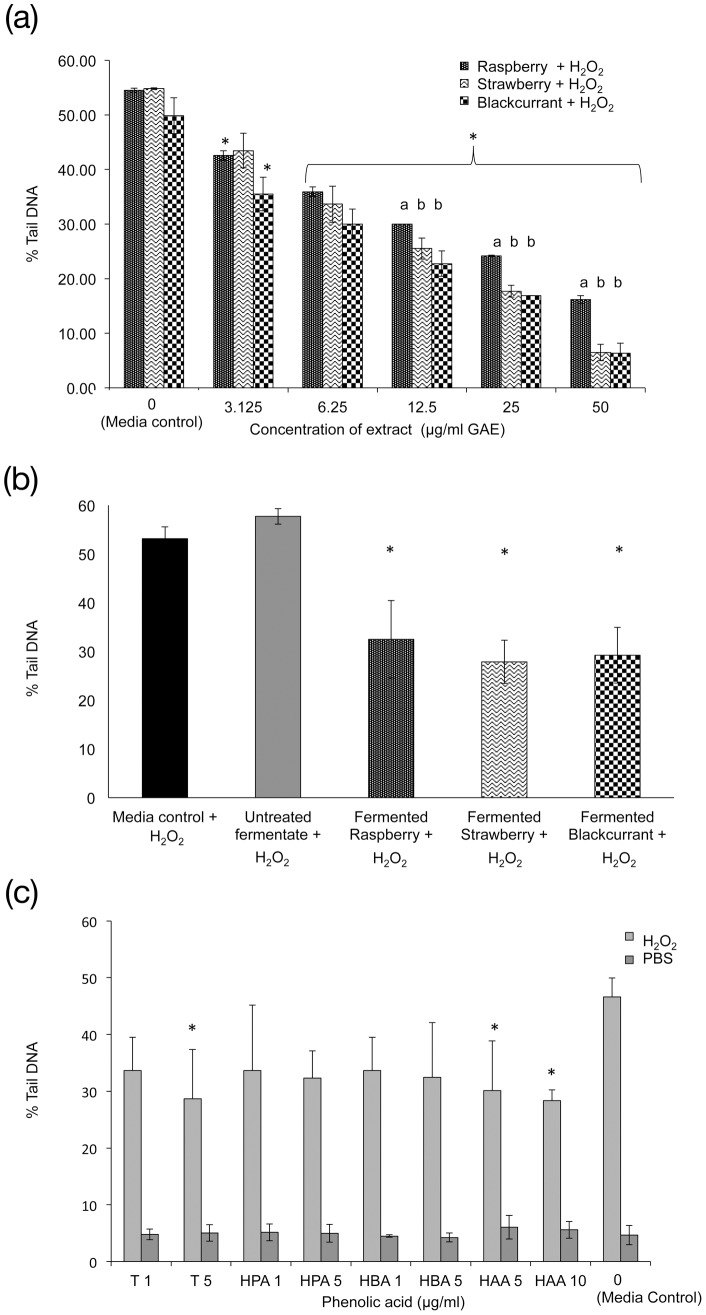
The anti-genotoxic effects of various types of berry extracts on HT29 cells.(A) Effects of IVD berry extract, (B) berry fermentates at a 1∶10 dilution after 24 hr pre-incubation on DNA damage in HT29 cells challenged with 75 µM H2O2 (phenol levels for berry fermentates were raspberry 15.5, strawberry 13.9, blackcurrant 12.4 µg/mL GAE), (C) individual polyphenols – tyrosol (T), 3-(3′-hydroxyphenyl)propionic acid (HPA), 4-hydroxybenzoic acid (HBA), 4′-hydroxyphenylacetic acid (HAA) at 1, 5 or 10 µg/mL concentrations. Data is presented as mean of 3 independent experiments + SD. One-way ANOVA and Dunnett T test, * p<0.05, significance is compared to media control (0 µg/mL) for A & C and against control fermentate in B. Bonferroni 4-way comparison, bars with different letters are significantly different from each other p<0.05.